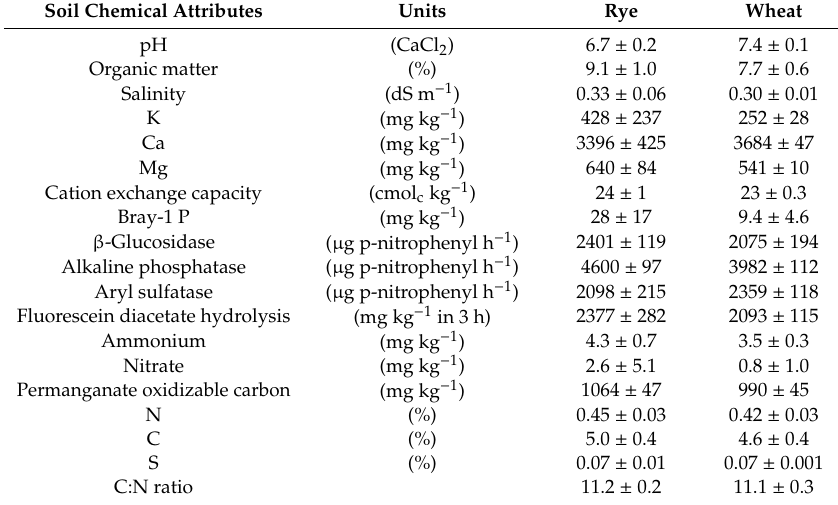
Table 1. Soil chemical attributes in 0–15 cm before the field trial at the Minnesota site.